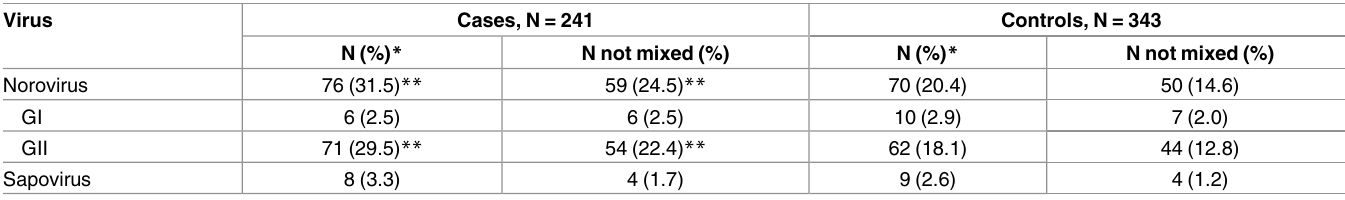
Table 2. Norovirus and sapovirus detected in cases and controls.